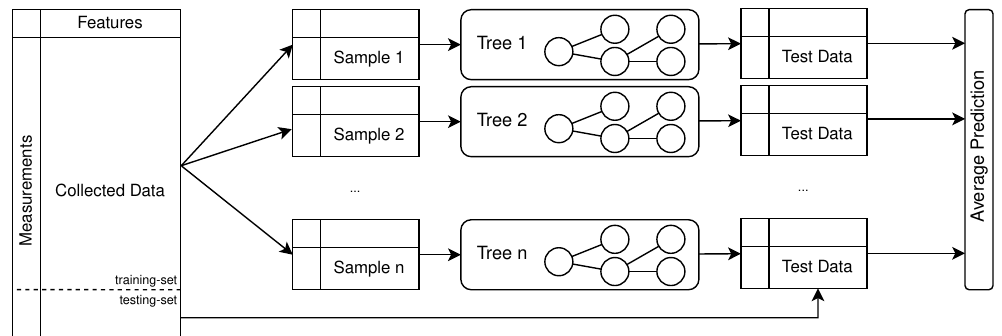
Figure 3. A Random Forest algorithm with n trees. A subsample of the original data are used to build each tree. The final prediction is the average between all the n trees